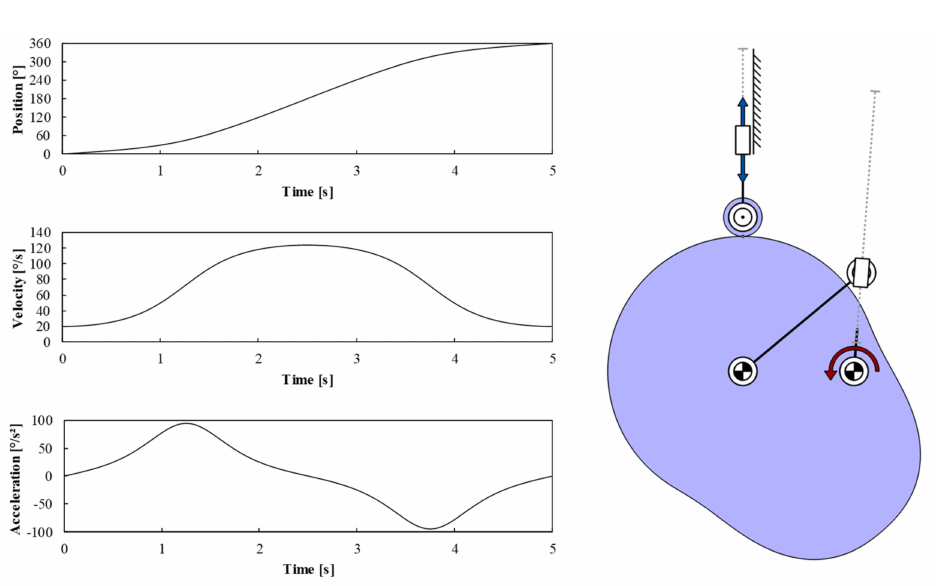
Figure 5. Rothbart: input motion of the cam (left) and resulting mechanism